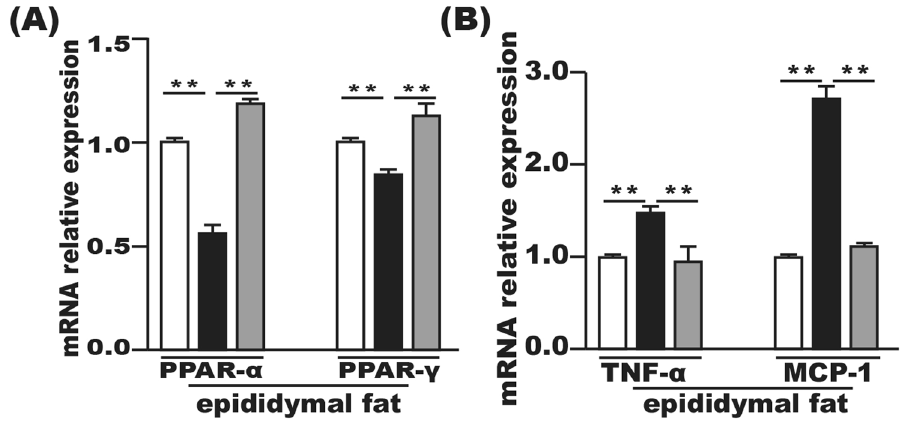
Figure 6. FMT improved inflammation and lipid metabolism in epididymal fat tissue. (A) Lipid metabolism- associated PPAR- α and PPAR- γ gene expression in the epididymal fat tissue. ( B ) Gene expression levels of MCP-1 and TNF- α in the epididymal fat tissue. Gene expression levels are expressed as values relative to the control group. The data represent the mean ± S.E.M. (n = 12 mice per group), * P < 0.05, ** P < 0.01 and *** P <